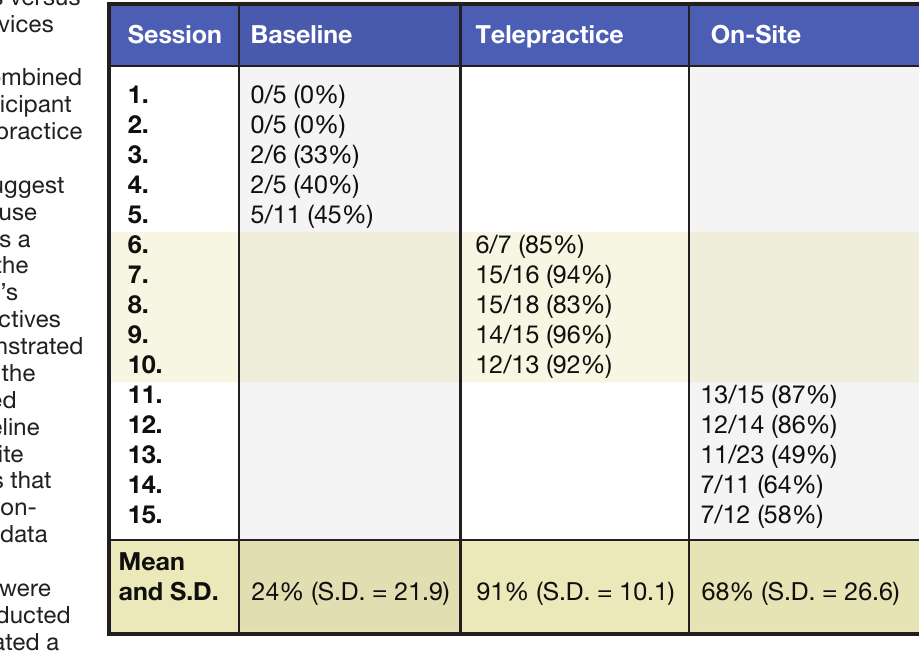
Table 2. Participant Baseline, On-site and Telepractice Probe Data (reported in combined raw data and